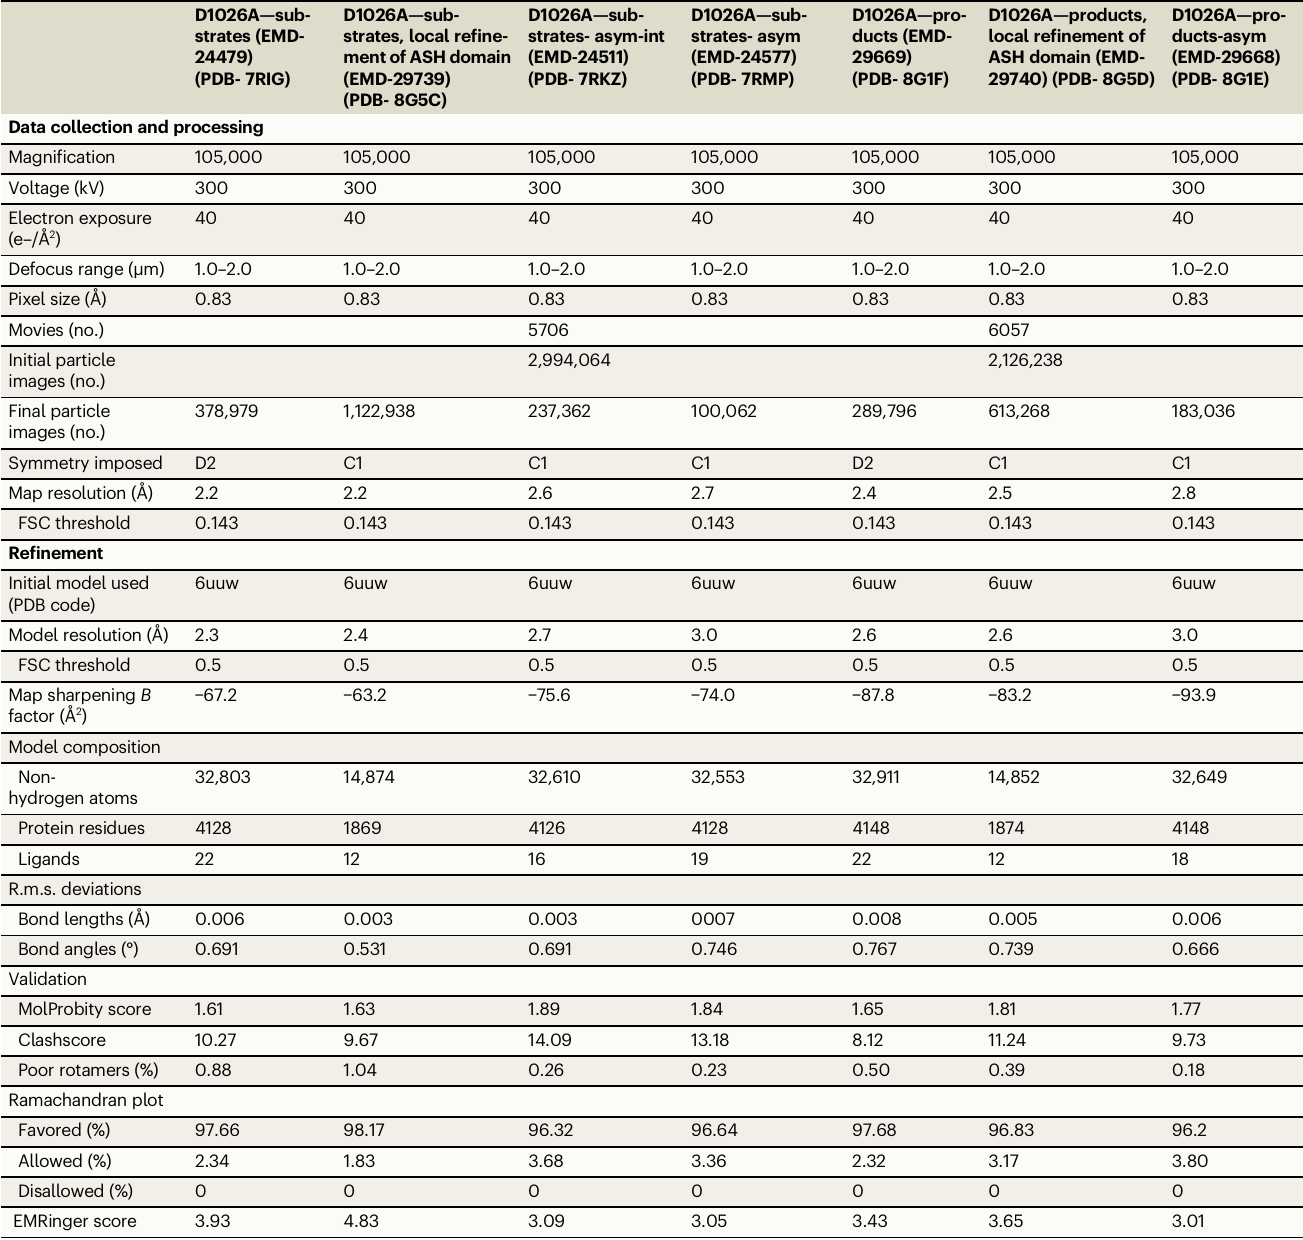
Table 1 | Cryo-EM data collection, re fi nement, and validation statistics D1026A — sub- strates (EMD-